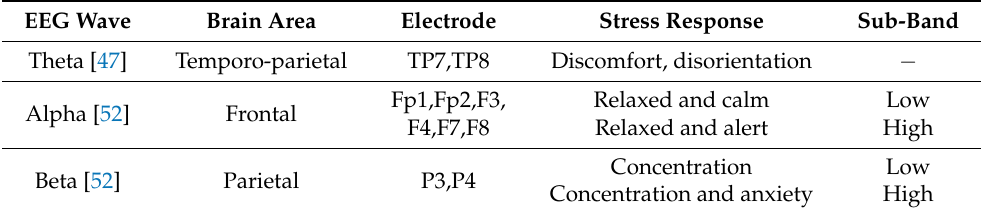
Table 2. EEG brain activity with respective stress responses.